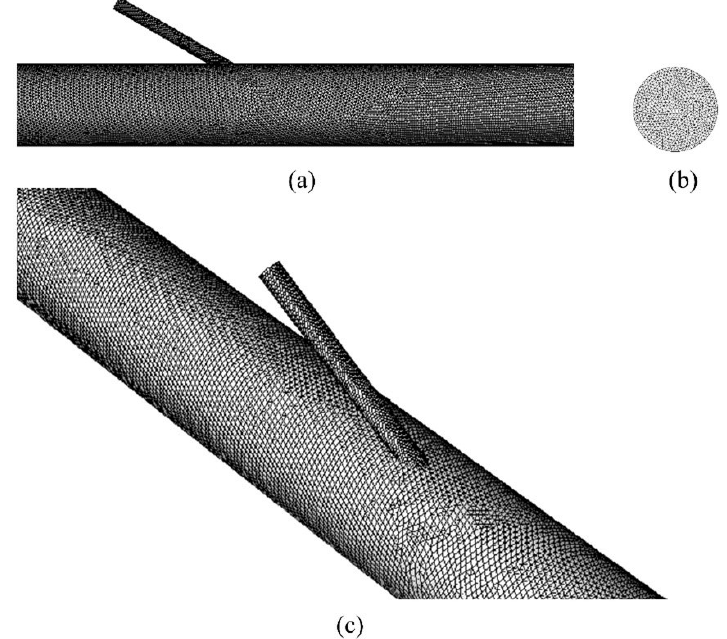
Figure 2. Typical mesh distribution in simulation of T-junction with φ = 51.4 mm, θ = 30°. ( a ) Side view, ( b ) cross-sectional view, and ( c ) 3-D view.